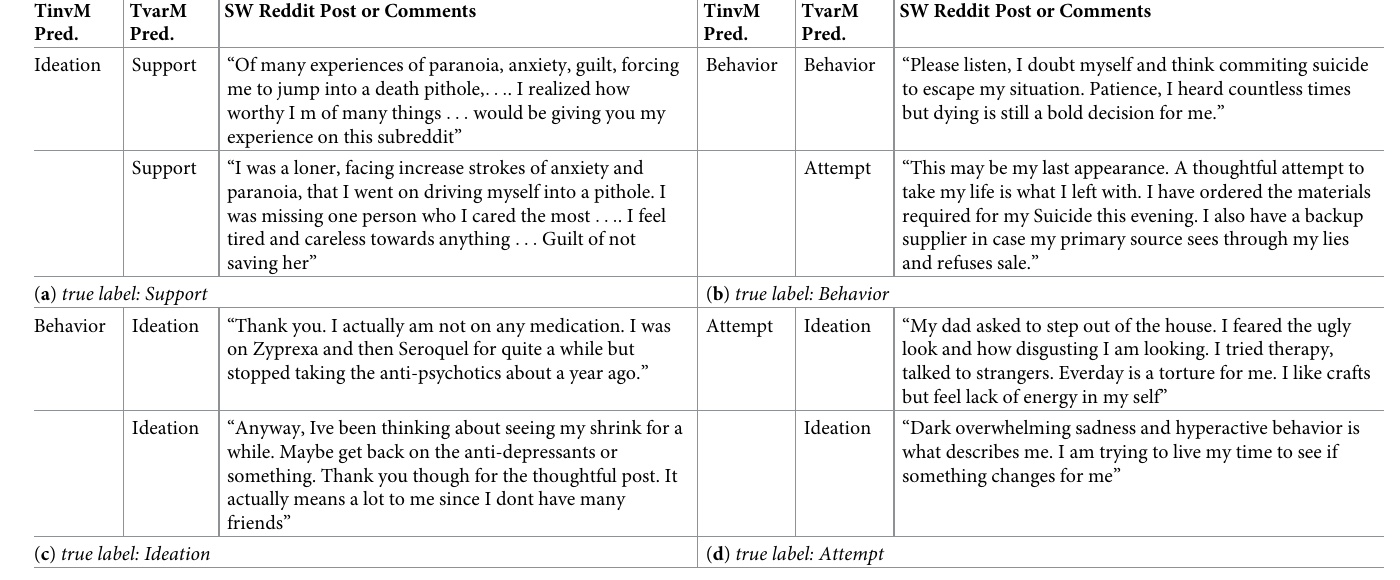
Table 8. Qualitative comparison of TinvM and TvarM models representative posts from users who are either supportive or showing signs of suicide ideations, behaviors or attempt. TinvM TvarM Pred.